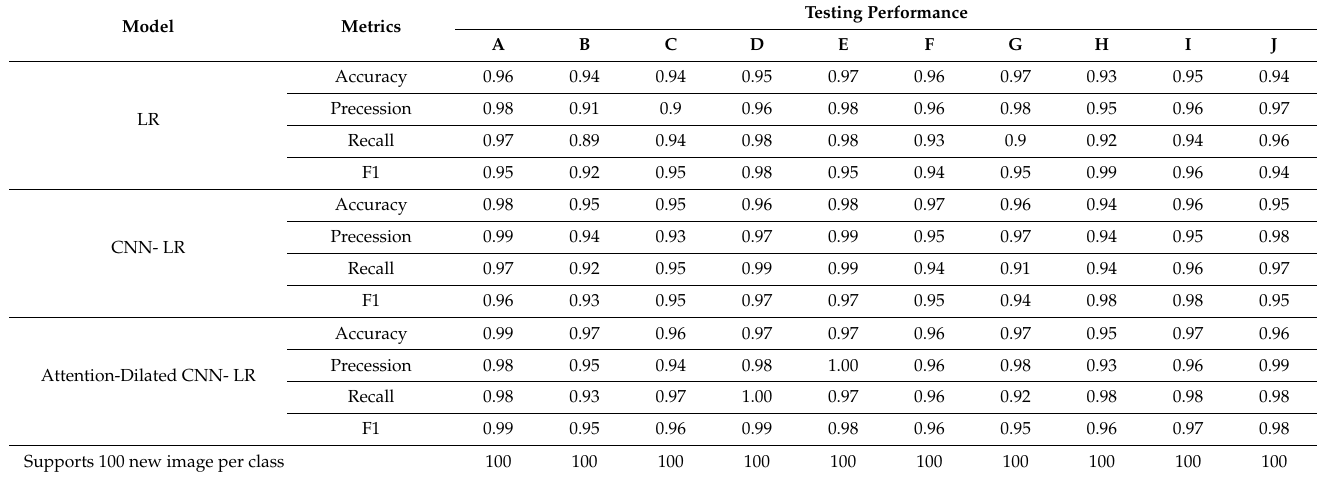
Table 5. Testing performance of ADCLR model.